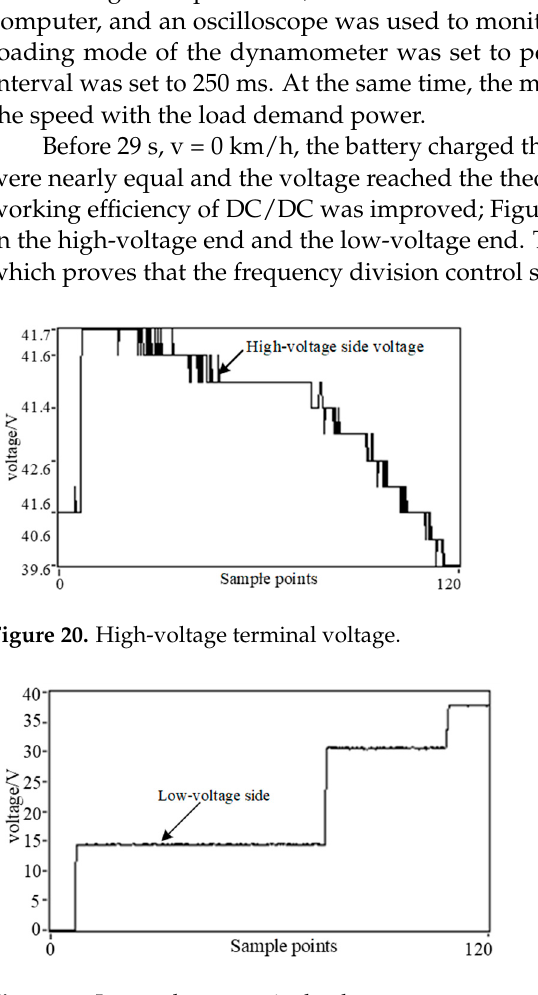
Figure 22. Motor controller current when climbing with constant speed. Figure 23. Battery and super-capacitor currents when climbing with constant speed.